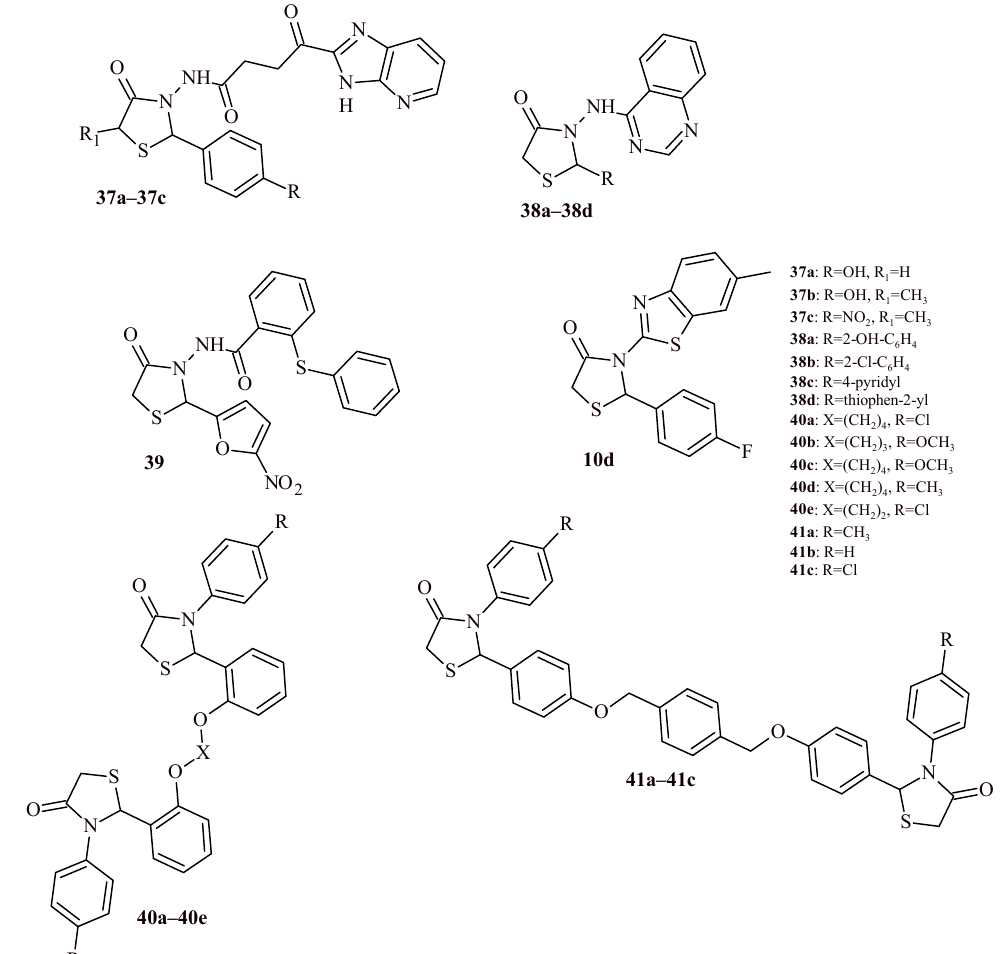
Figure 17. The 2-Aryl-3-aryl/arylaminothiazolidin-4-one derivatives with anticancer activity. The thiazolidine-4-one derivative ( 39 ) with 5-nitrofuran-2-yl substituent exhibited promising anti-breast cancer activity in the in vitro and in vivo tests. The IC 50 values for anticancer activity of Compound 39 against human cancer cell lines were 1.9 µM (MDA- MB-231), 5.4 µM (HepG2), 6.5 µM (HT-29) and 13.51 µM towards normal cell line HGF-1,